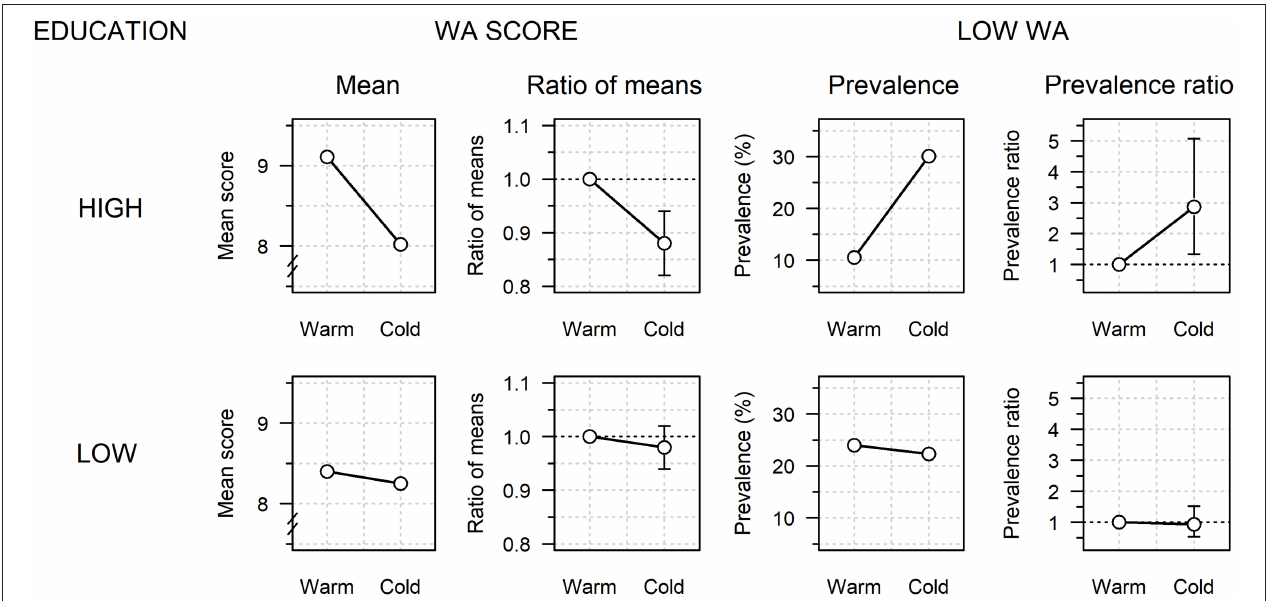
FIGURE 2 | Perceived work ability (WA) according to worksite temperature (warm, 10–23 ◦ C; cold, − 22–10 ◦ C) among highly- and less-educated workers. Mean WA score and prevalence of a low WA score ( < 8) are based on a temperature × education interaction model after adjustment for sex, age, job category, physical work strain, moving between cold and warm sites, thermal insulation of clothing, relative humidity, and air velocity. The cold vs. warm ratios of the model-adjusted means and adjusted prevalence ratios are also shown (vertical bars: 95% CIs).